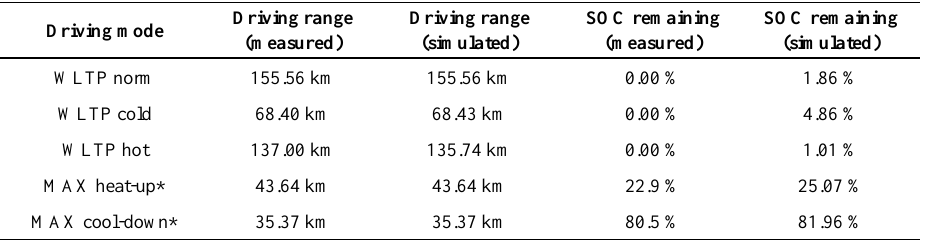
Table 1. Measured vs. simulated (baseline) driving ranges